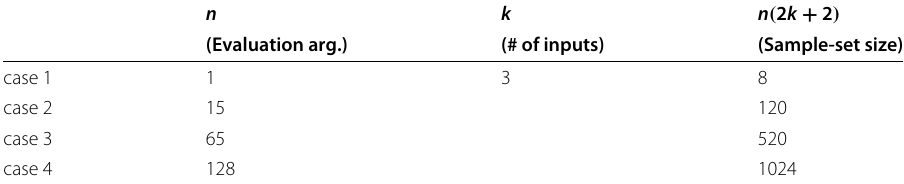
Table 1 Saltelli sampler